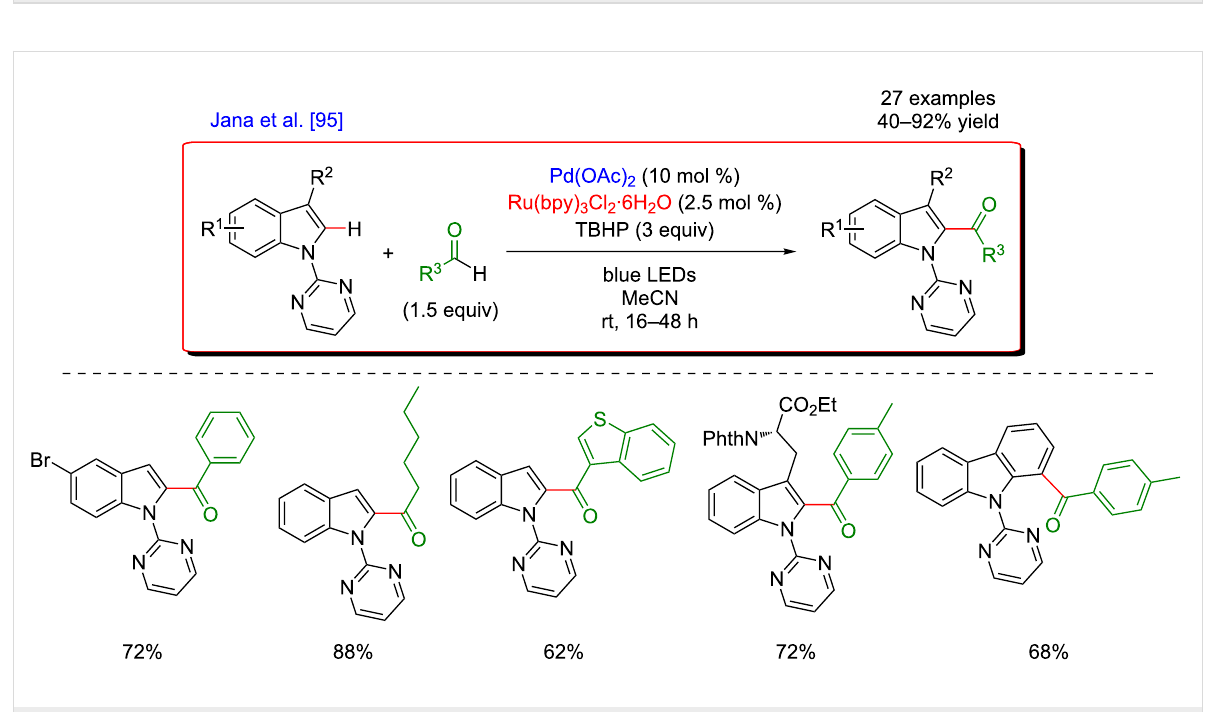
Figure 32: C2-acylation of indoles via the dual C–H activation/photoredox